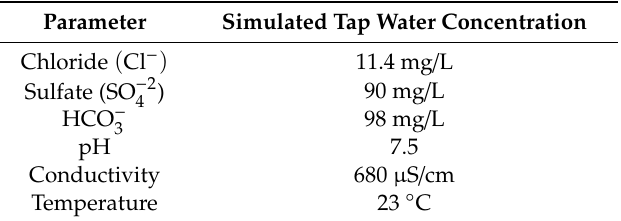
Table 1. Chemical composition of simulated tap water used as an electrolyte in the electrochemical